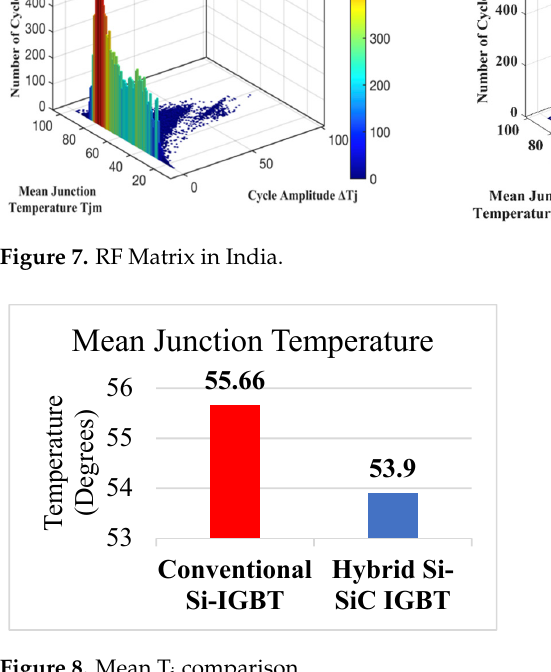
Figure 8. Mean T j comparison.